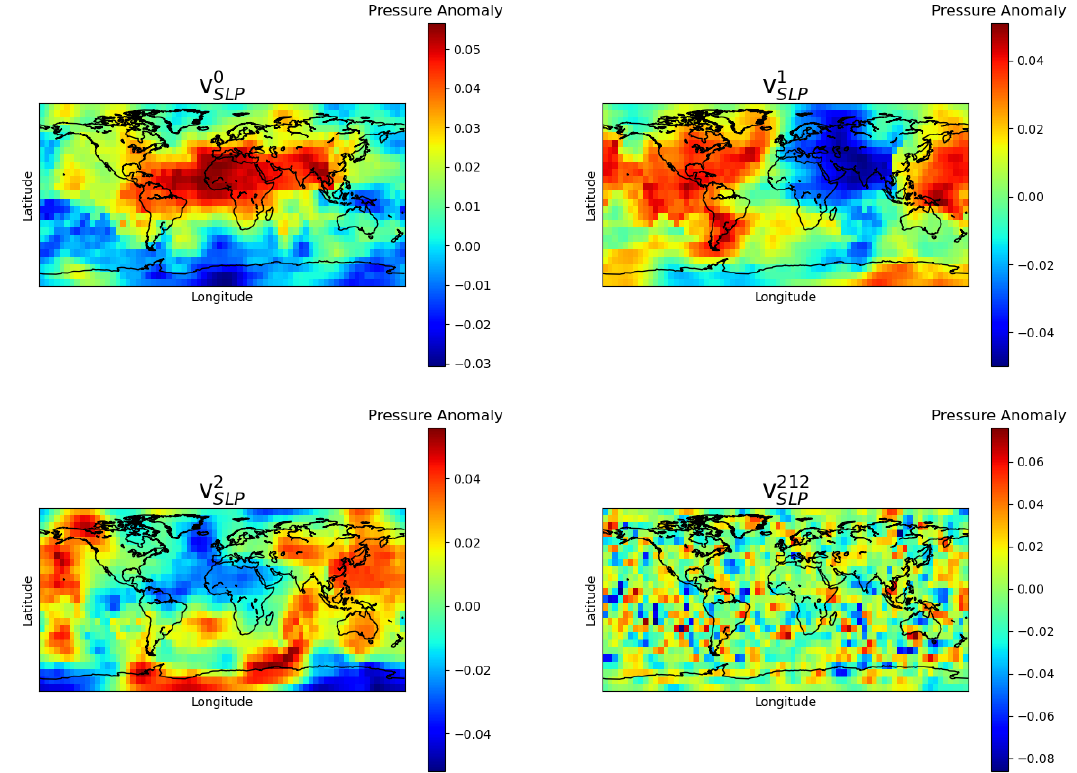
Γ , v 1 , v 2 and v 212 for SLP . SLP SLP SLP SLP